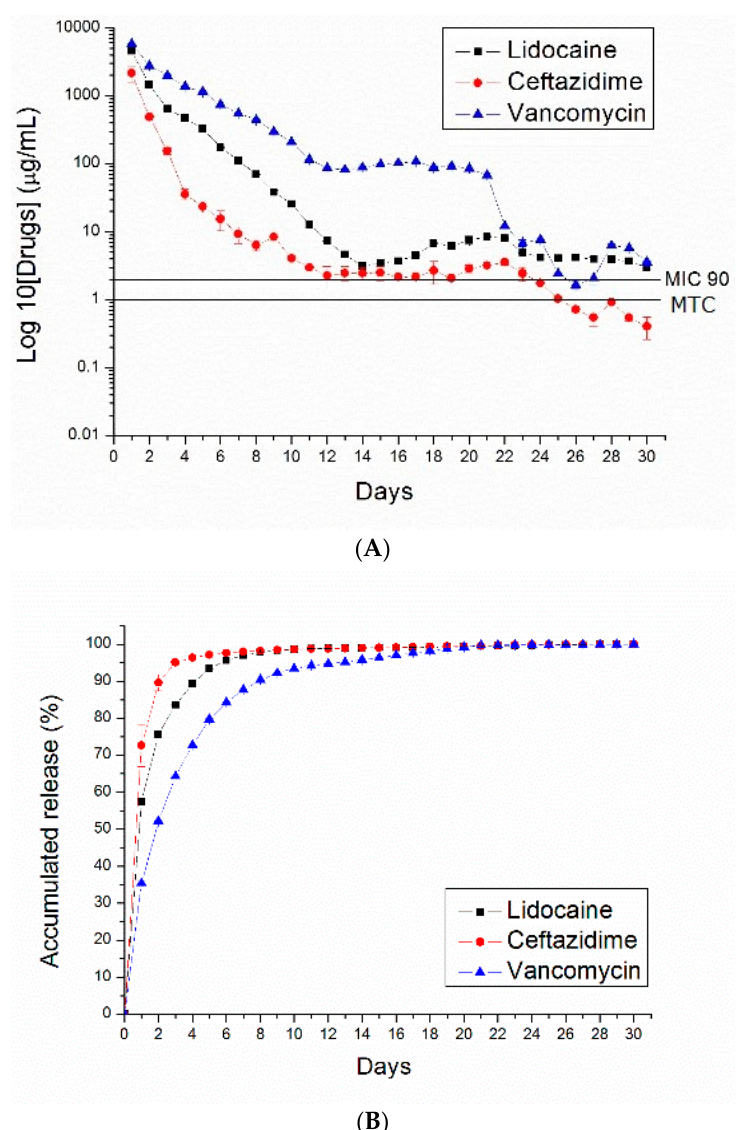
Figure 9. PLGA (50:50)—( A ) daily and ( B ) accumulated release curves of pharmaceuticals from 200 mg PLGA nano/microparticle-loaded buffered solution.